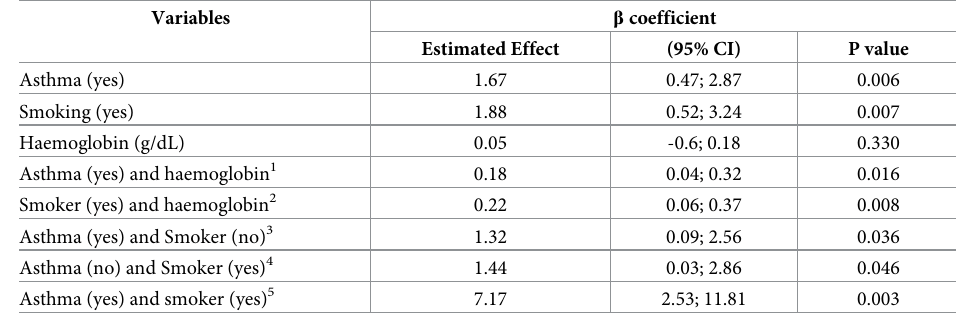
Table 4. Results of linear regression of asthma, smoking and